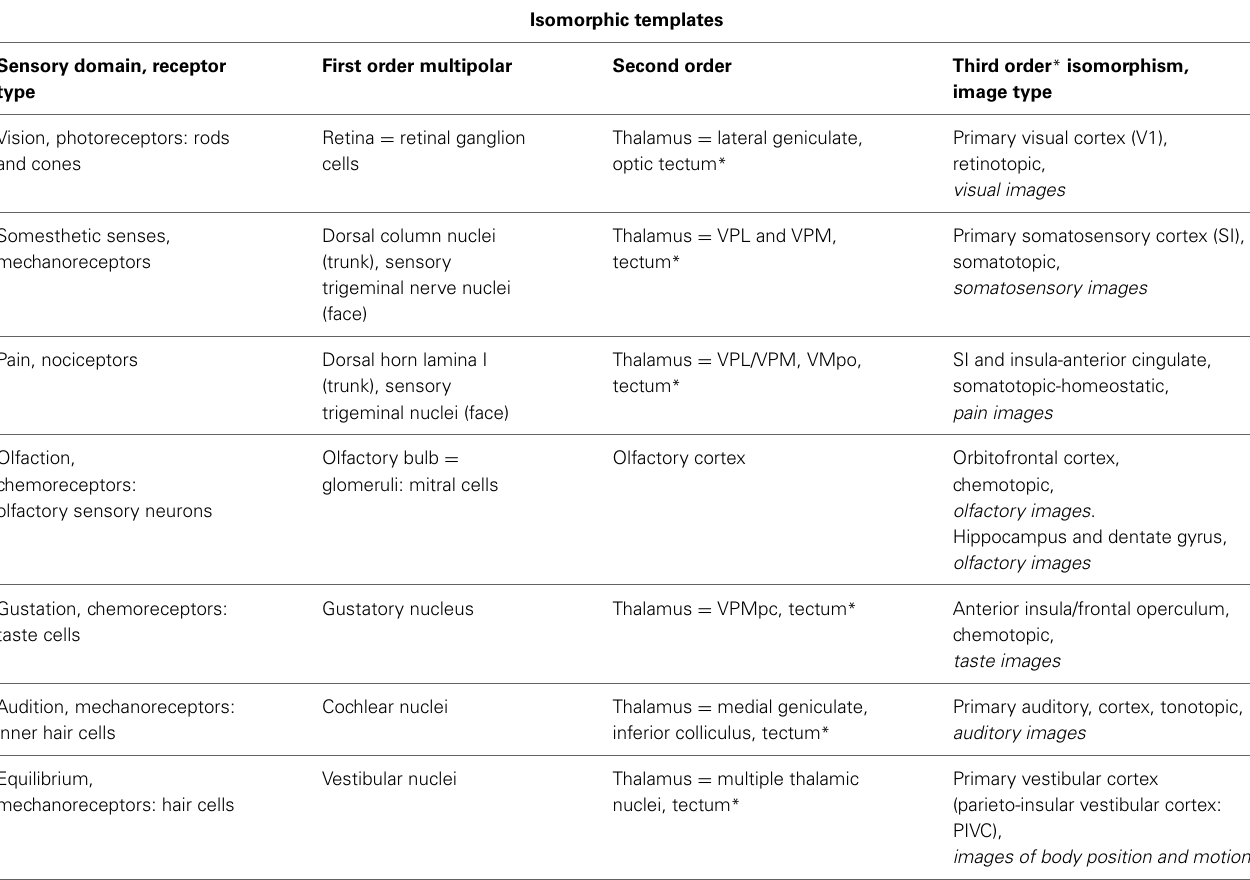
Table 1 | A simplified summary of some of the major sensory receptors and isomorphic pathways leading to sensory mental